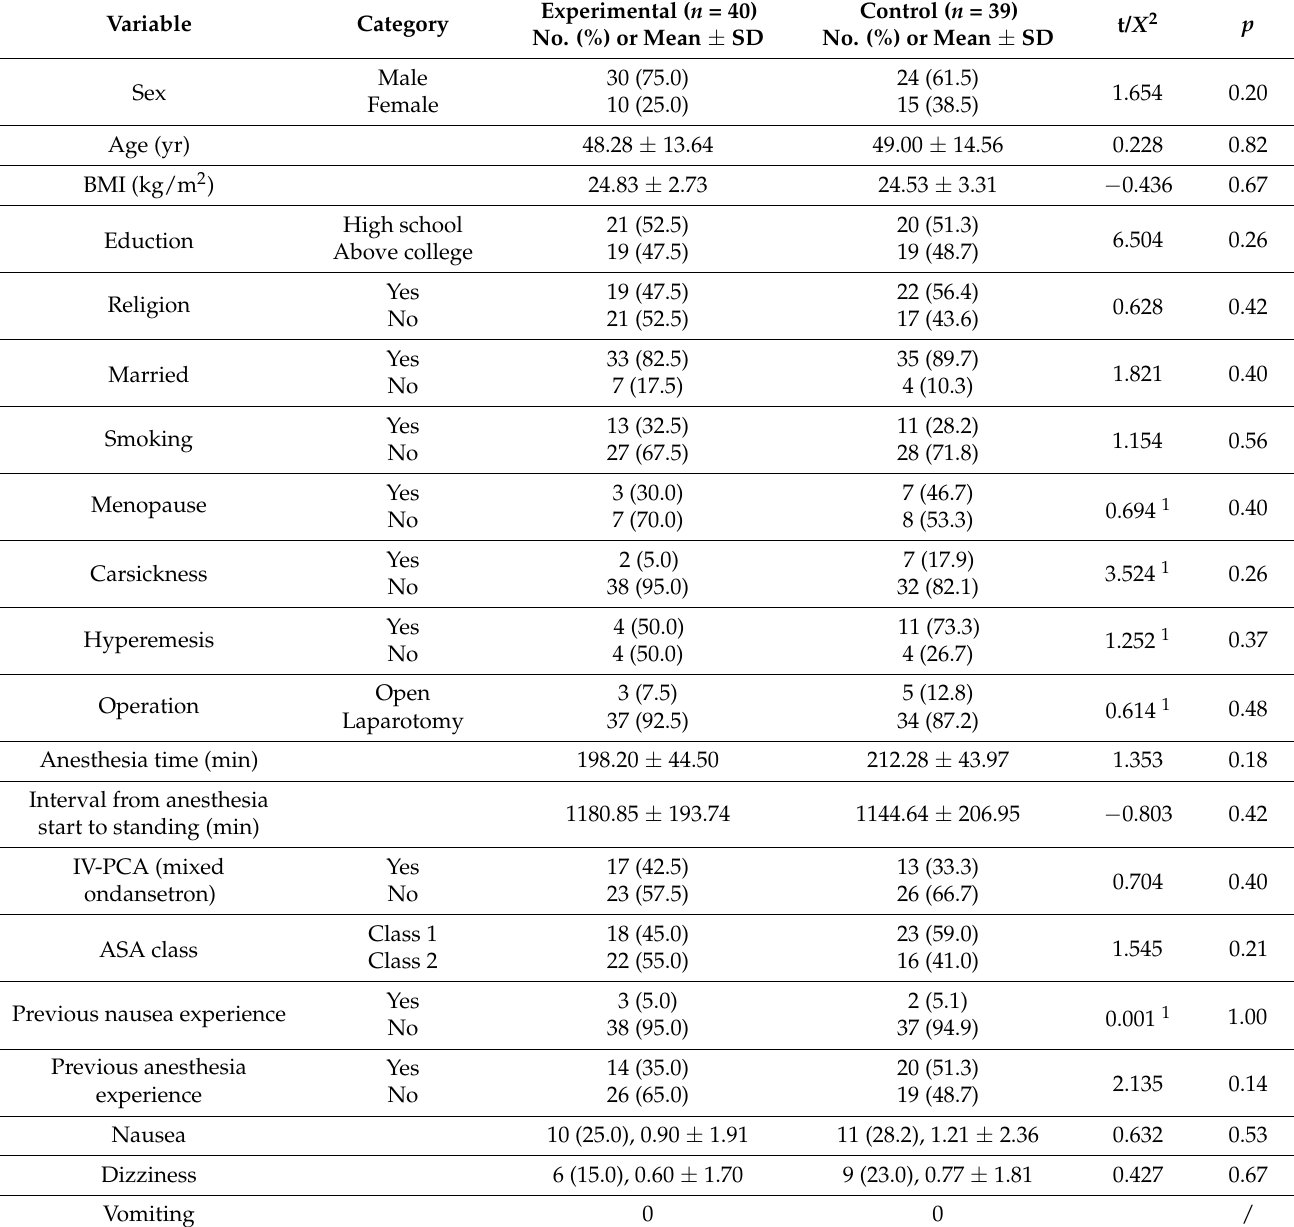
Table 2. Homogeneity tests between the two groups at baseline ( n =